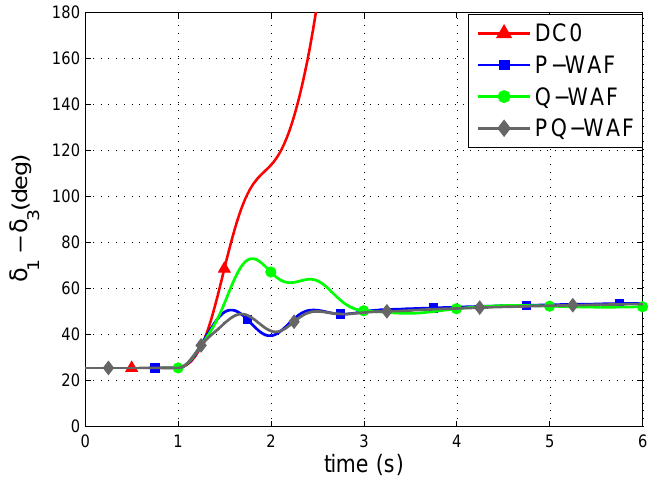
Figure 8. Generator angle